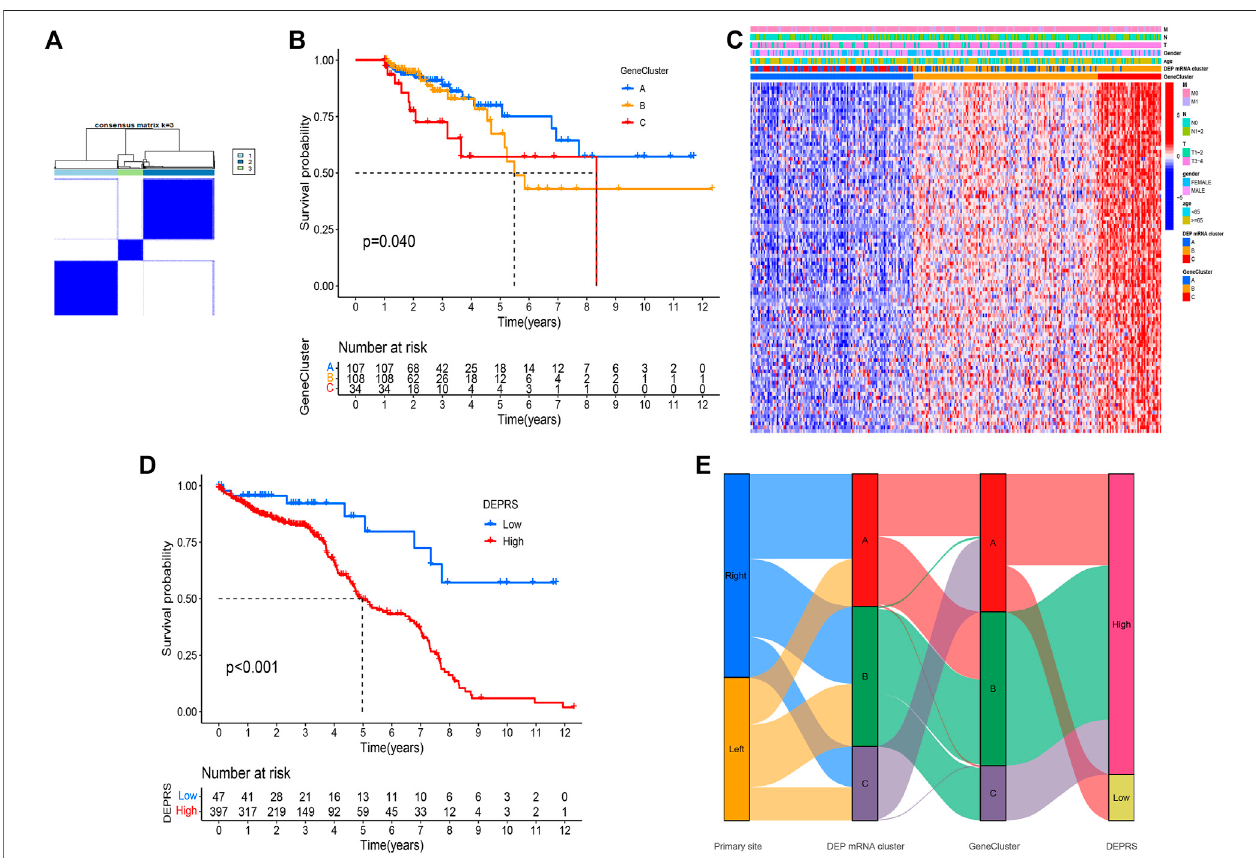
FIGURE 4 | (A) Consensus matrixes of TCGA-COAD cohorts for appropriate k value (k = 3), displaying the clustering stability using 1,000 iterations of hierarchical clustering. TCGA samples were clustered into three subtypes based on the DEGs among three DEP mRNA clusters. (B) Kaplan – Meier curves showing the overall survival across the gene clusters. The log rank test showed an overall p = 0.040. (C) A heat map showing the expression of DEGs in different gene clusters. Heat map colors indicate relative DEGs expression levels. (D) Kaplan – Meier curves showing the overall survival in high-DEPRS and low-DEPRS groups. The log rank test showed an overall p < 0.001. (E) The Sankey diagram displaying the distribution of patients with primary tumor sites, DEP mRNA clusters, gene clusters, and